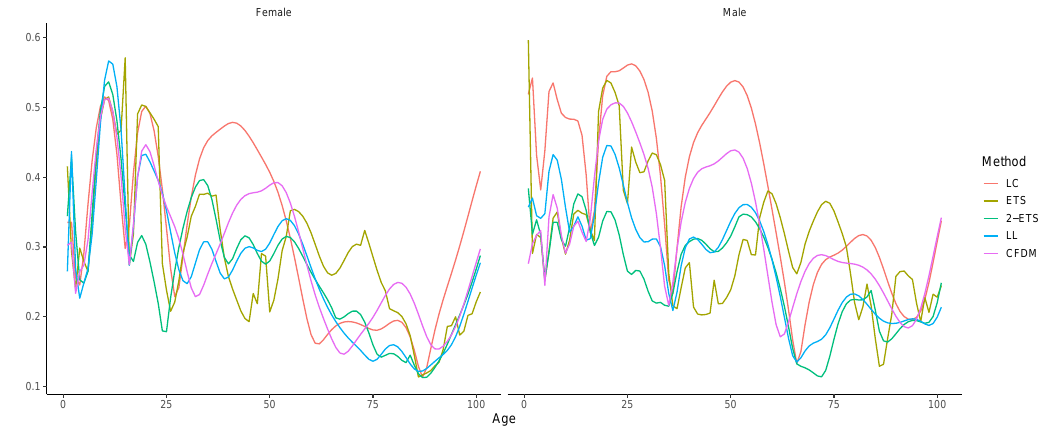
Figure 4. RMSE x , i plotted against age groups for Australian mortality data. Table 1. Summary of RMSEs over age groups for the forecast of Australian female (Panel A) and male (Panel B)